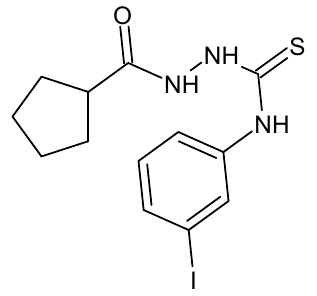
Figure 20. The structure of 1-cyclopentanoyl-4-(3-iodophenyl)thiosemicarbazide.